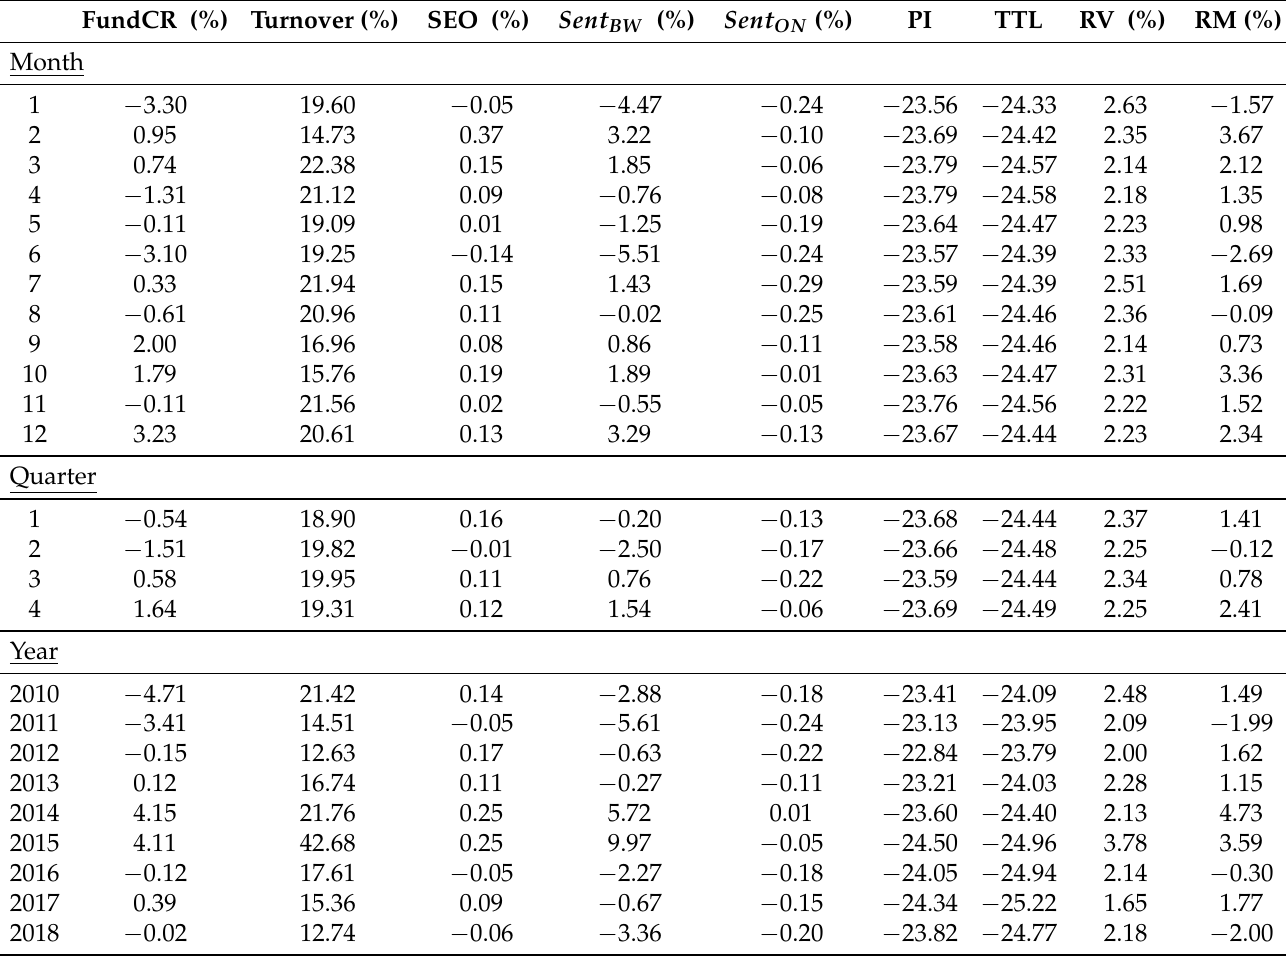
Table 4. Seasonality analysis of variables of